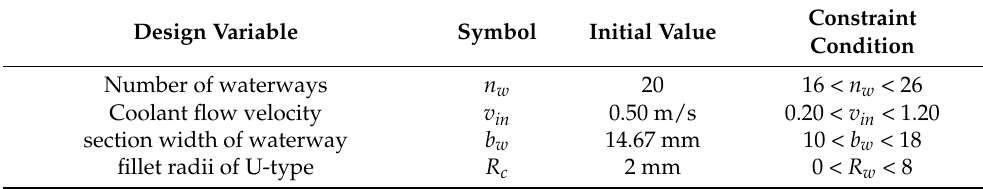
Table 3. Preset ranges of design